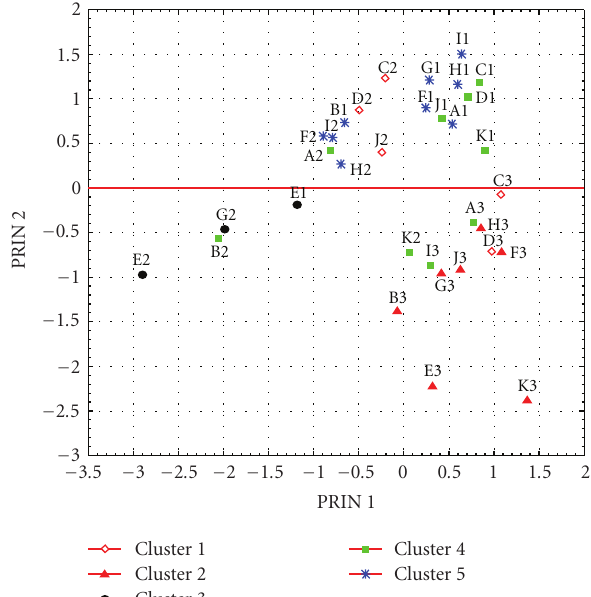
Figure 2: Graphic representation of hybrid behaviour according to first two principal components and identification of clusters for early sowing date (S1). Behaviour is represented by a letter (hybrid code) and a number (location-year code).